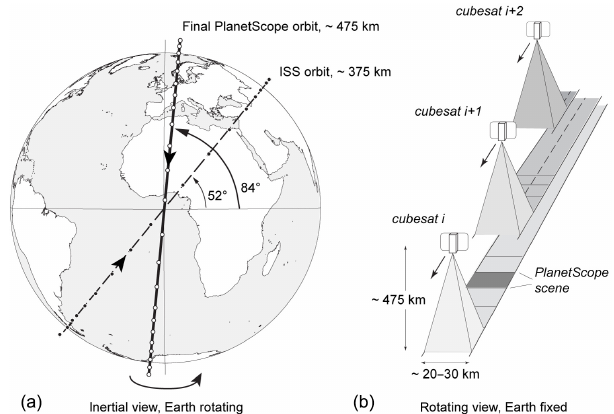
Figure 2. (a) Final PlanetScope orbit and ISS test-bed orbit. Cube- sat positions (white and black dots on the orbit) are only schemati- cally indicated. The final PlanetScope orbit is planned to host over 100 cubesats. (b) Scheme of complete scan of the Earth surface by successive PlanetScope cubesats (called doves) in the same